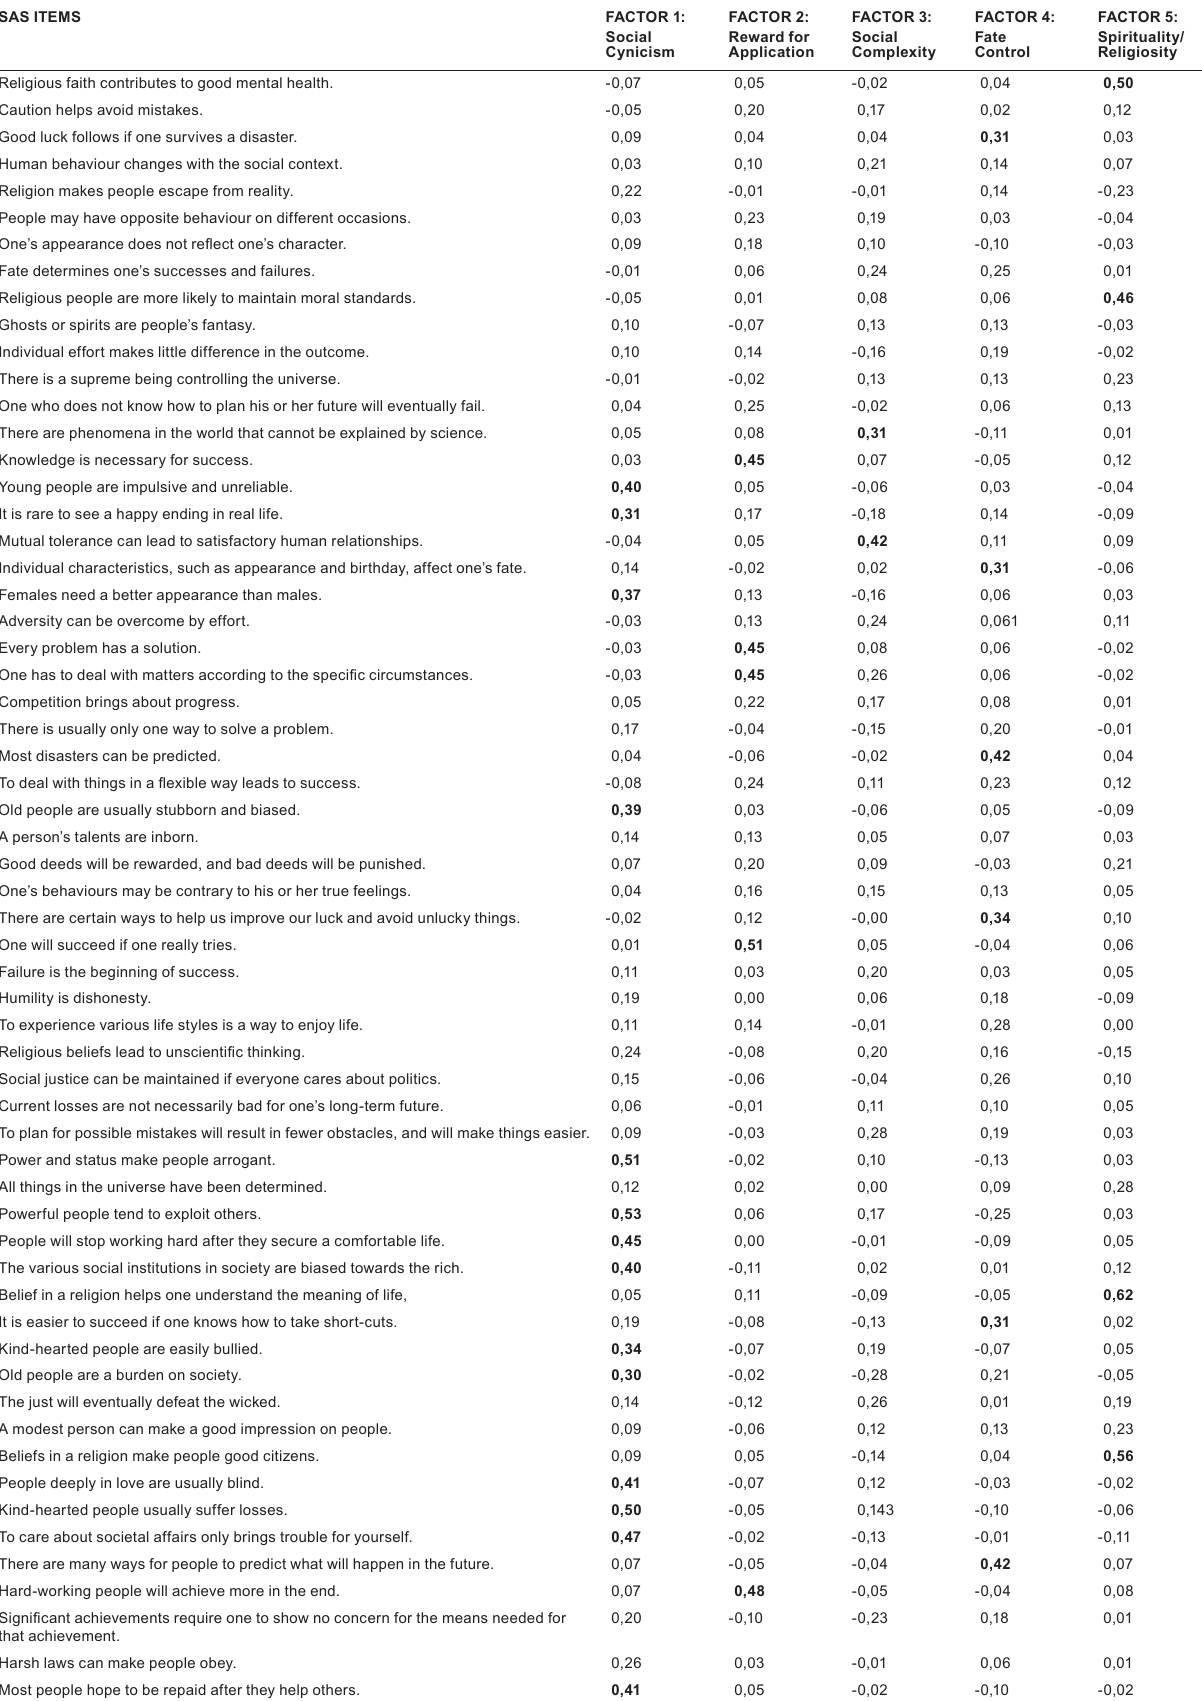
FActor 2: FActor 3: FActor 4: FActor 5: Social reward for Social Fate Spirituality/ cynicism Application complexity control religiosity